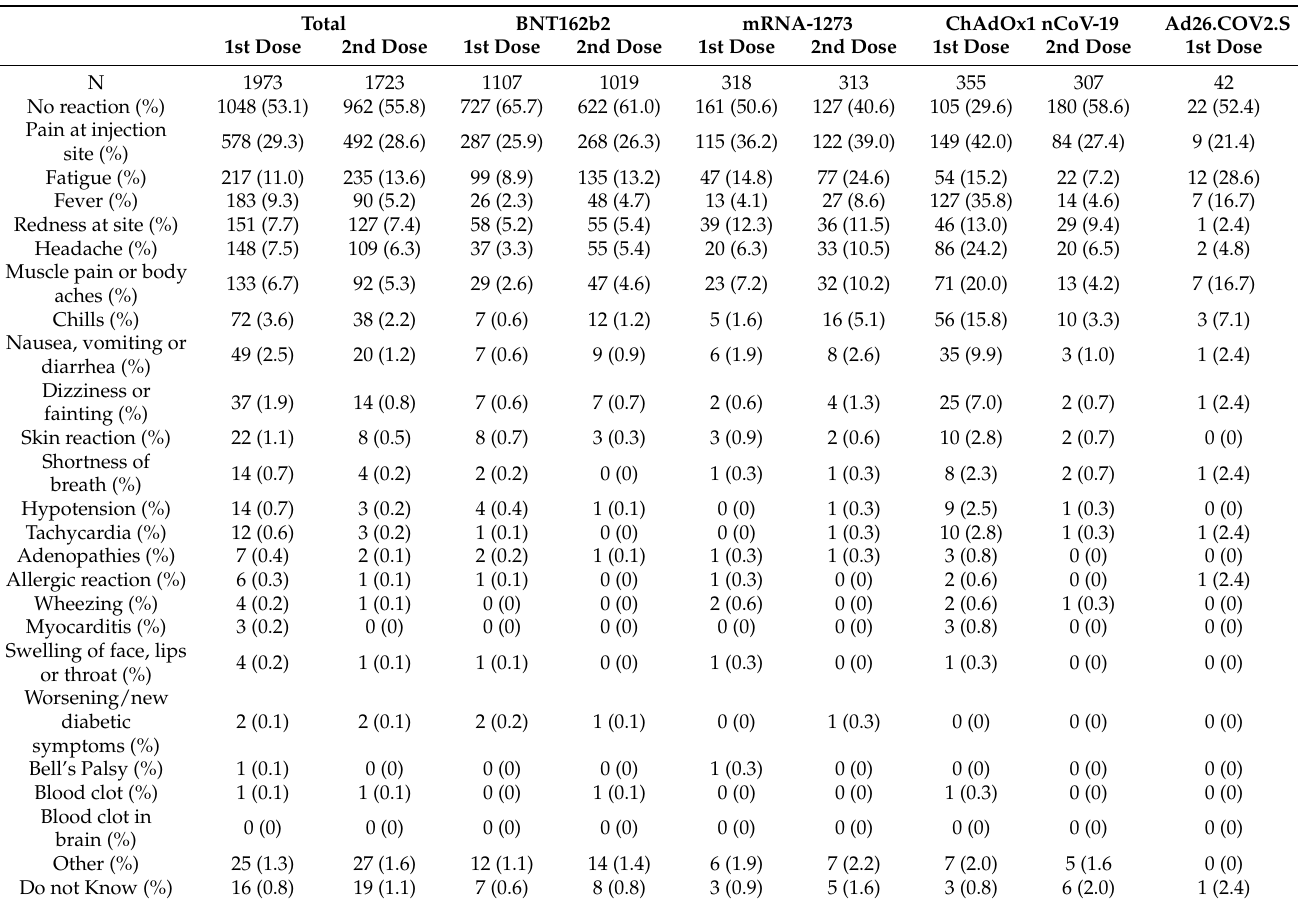
Numbers presented as n (%) of total doses administered stratified by 1st and 2nd dose of the vaccine; % were calculated after excluding missing information. More than half of the vaccinated individuals with DS (first dose: 1048 (53%), second dose: 962 (56%)) did not experience any side effects after receiving a COVID-19 vaccine (Table 2). The most common reactions were pain at the site of injection (first dose: 578 (29% of those who received a first vaccine dose), second dose: 492 (29% of those who received a second vaccine dose)), fatigue (first dose: 217 (11%), second dose: 235 (14%)), fever (first dose: 183 (9%), second dose: 90 (5%)), redness at the site of injection (first dose: 151 (8%), second dose: 127 (7%)), headache (first dose: 148 (8%), second dose: 109 (6%)), muscle pain or body aches (first dose: 133 (7%), second dose: 92 (5%)), and chills (first dose: 72 (4%), second dose: 38 (2%)). Severe side effects were rare. Of the 1973 vaccinated individuals with DS, three (0.2%) developed myocarditis after the first dose of ChAdOx1 nCoV-19, and two individuals had blood clots (one individual after their second dose of BNT162b2 (0.1%) and one individual after their first dose of ChAdOx1 nCoV-19